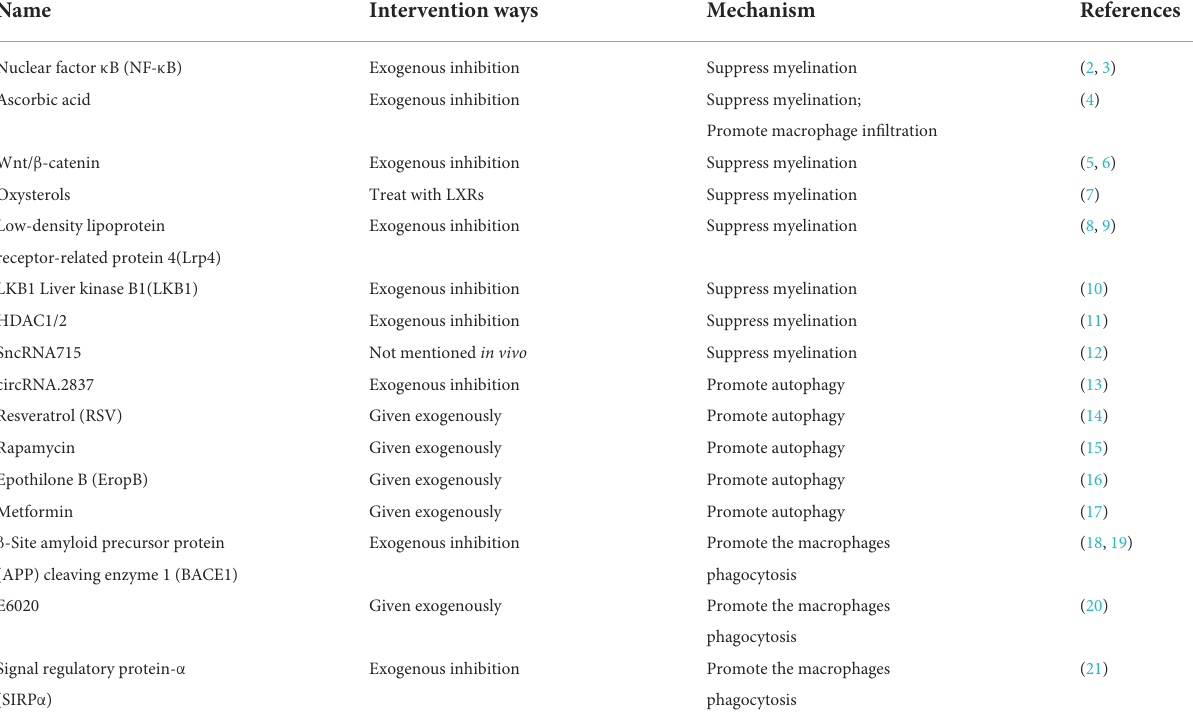
TABLE 1 Exogeneous